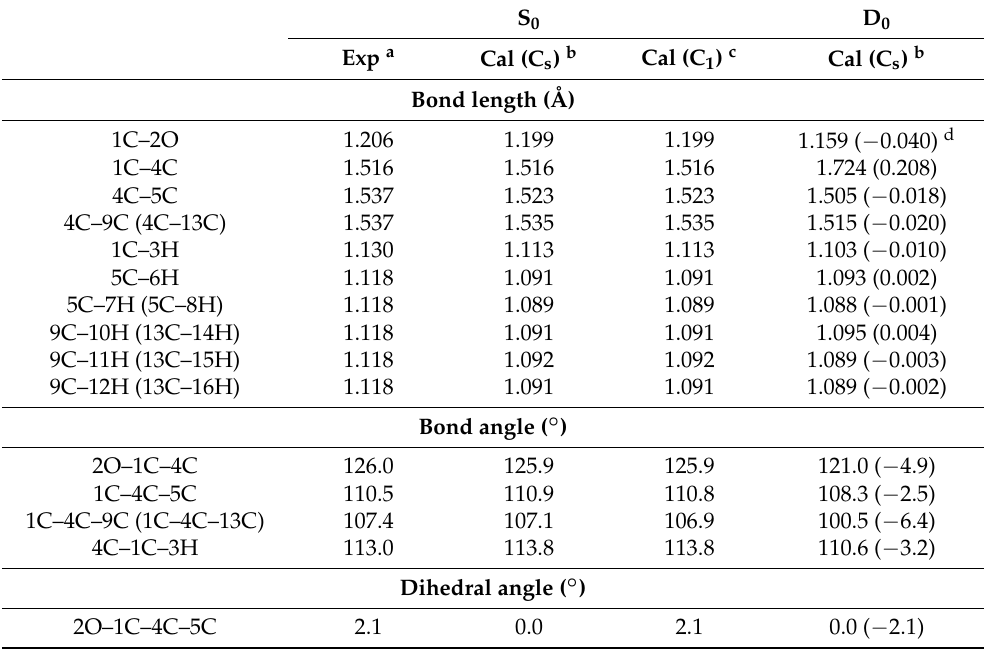
Table 2. Geometric parameters of pivaldehyde molecule in S 0 and D 0 states calculated at ω B97XD/cc- pVTZ